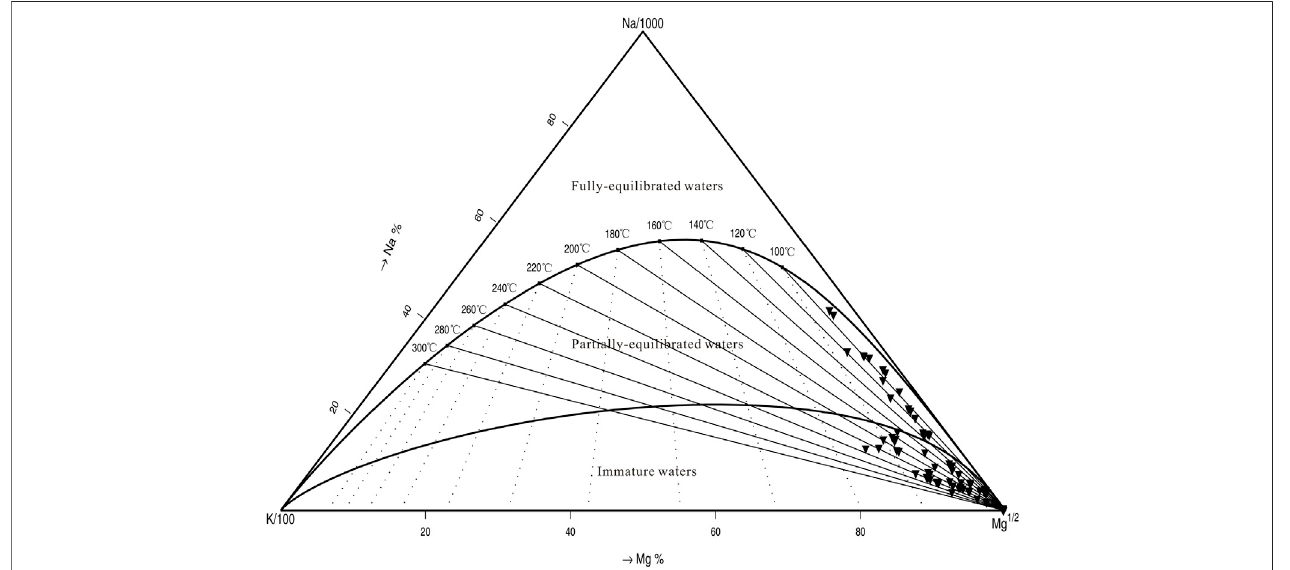
FIGURE 5 | The Na-K-Mg trilinear equilibrium diagram of hydrothermal water of the Simao Basin.